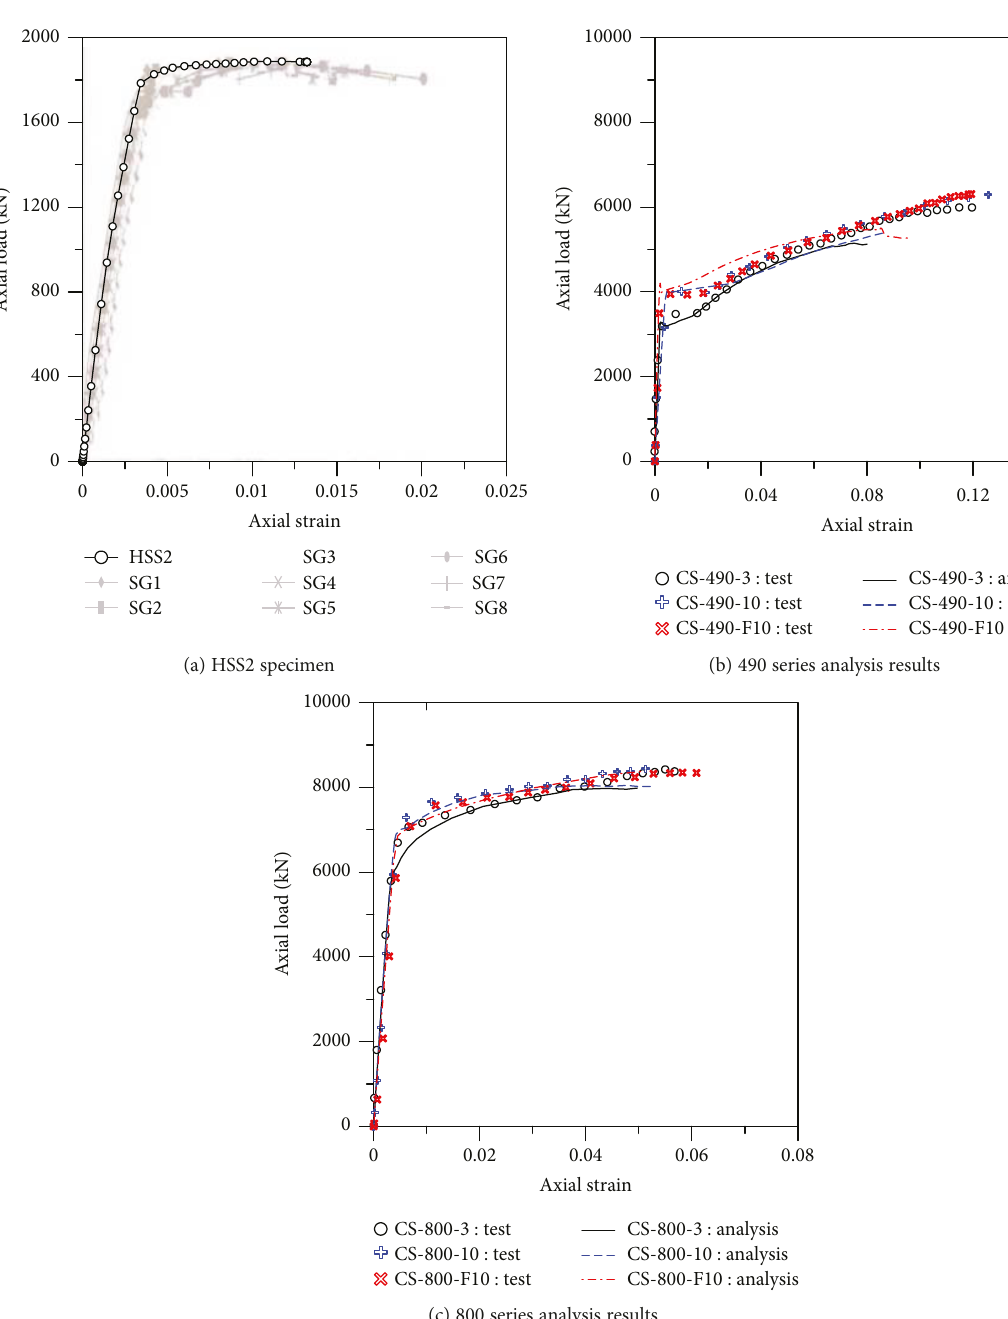
Figure 10: Veri fi cation of